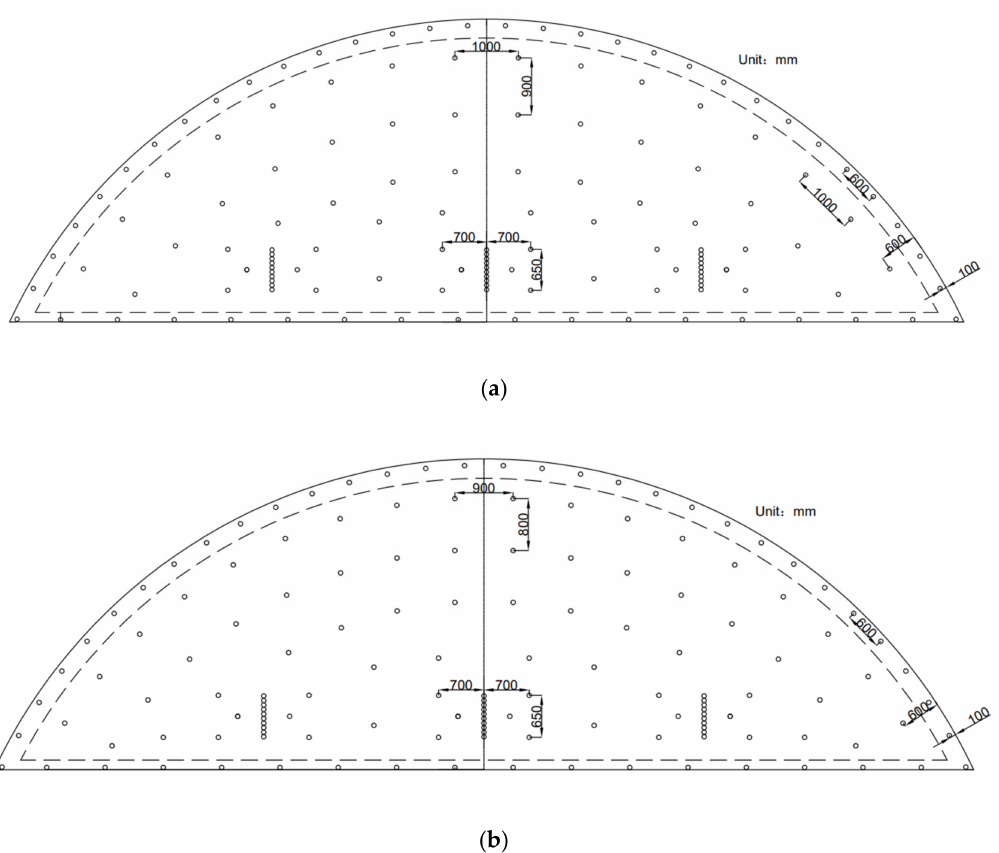
Figure 7. Plane arrangement of fracturing holes in the upper step excavation tests. ( a ) Test 3; ( b ) Test